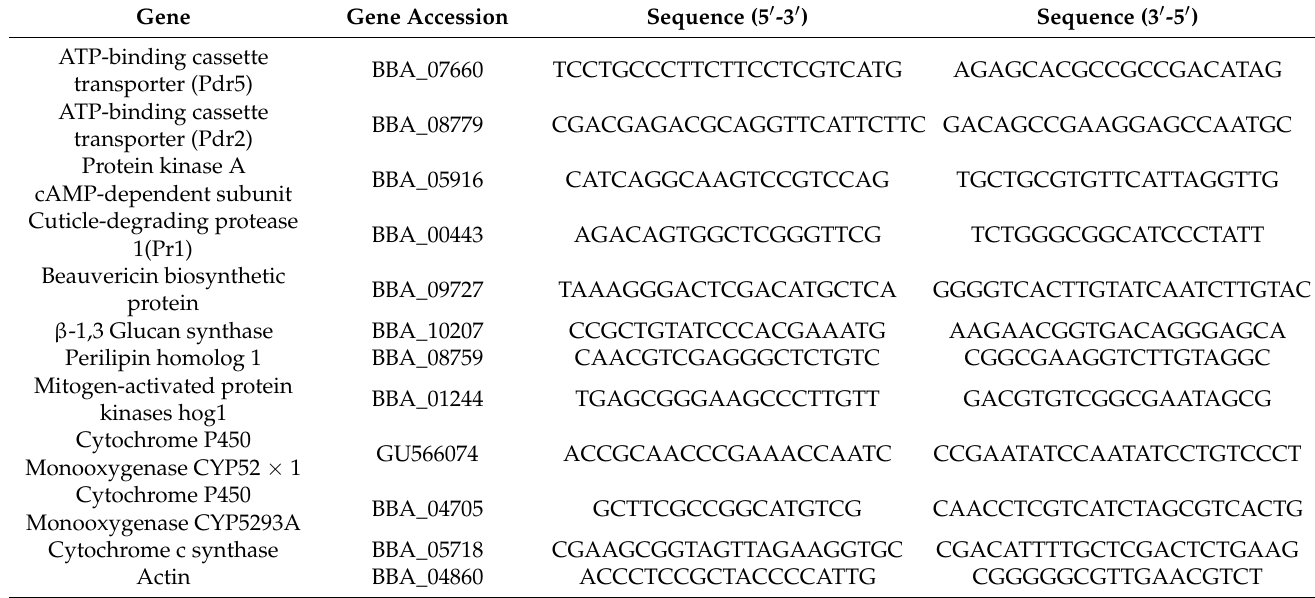
Table 1. Primers used in this research.